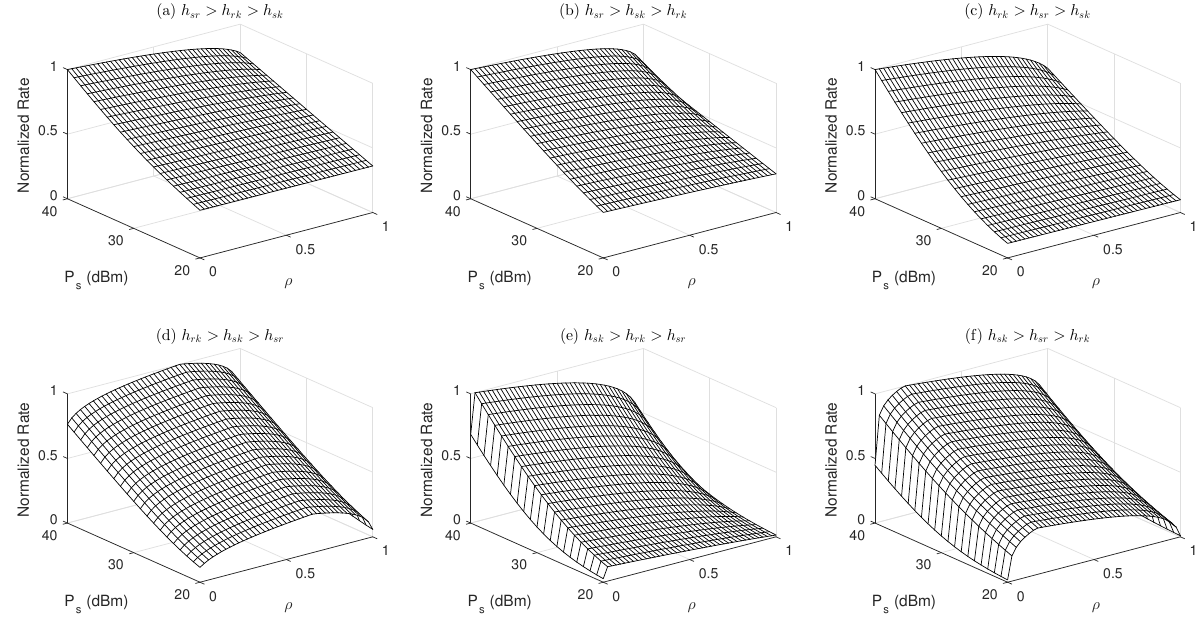
Figure 2. Objective function for different channel